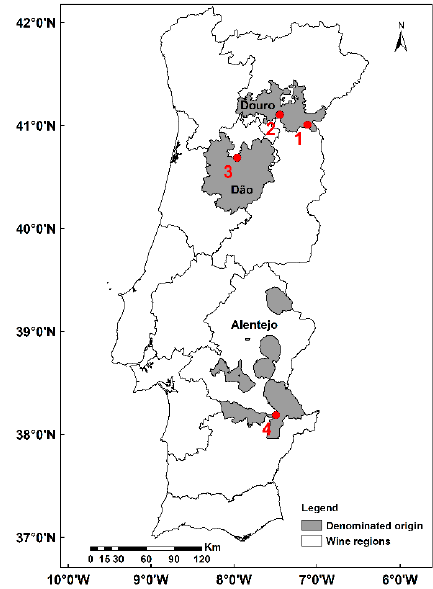
Figure 1. Winemaking regions where Sogrape Vinhos S.A. (SV) collected the data. The borders of the winemaking regions in Portugal are delimited as defined by the Portuguese Institute of Vine and Wine (IVV). Only Douro, Dão and Alentejo are selected in the present study, as longer periods of data are available for these three regions. The locations of the selected vineyards are also shown: 1—Douro-D, 2—Douro-C, 3—Dão and 4—Alentejo. Table 1. Selected maturation data. Wine region, sub-region, vineyard designation, vine block area, variety (Touriga Nacional, TON, and Aragonez, ARA) and the period of the records are listed. Wine Region